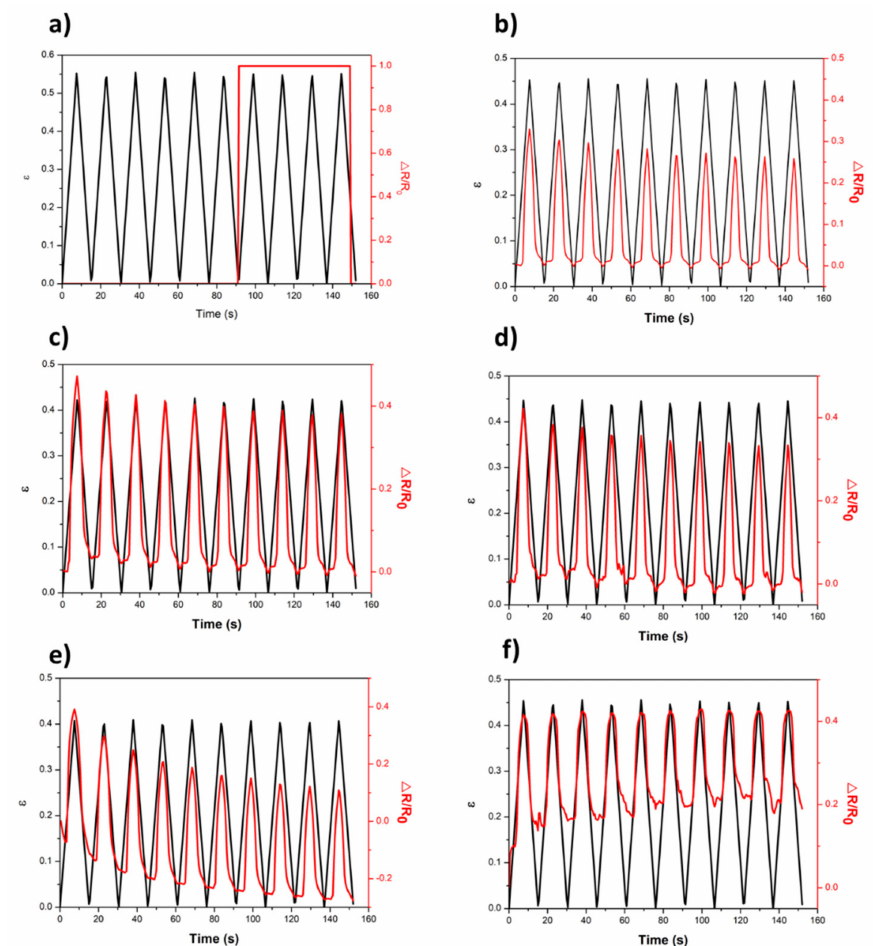
Figure 9. Piezoresistive response of flax fabric with di ff erent percentages of GNPs. ( a ) Flax, ( b ) FlaxCPG, ( c ) FlaxCPG + 0.1%, ( d ) FlaxCPG + 0.5%, ( e ) FlaxCPG + 1%, and ( f ) FlaxCPG +